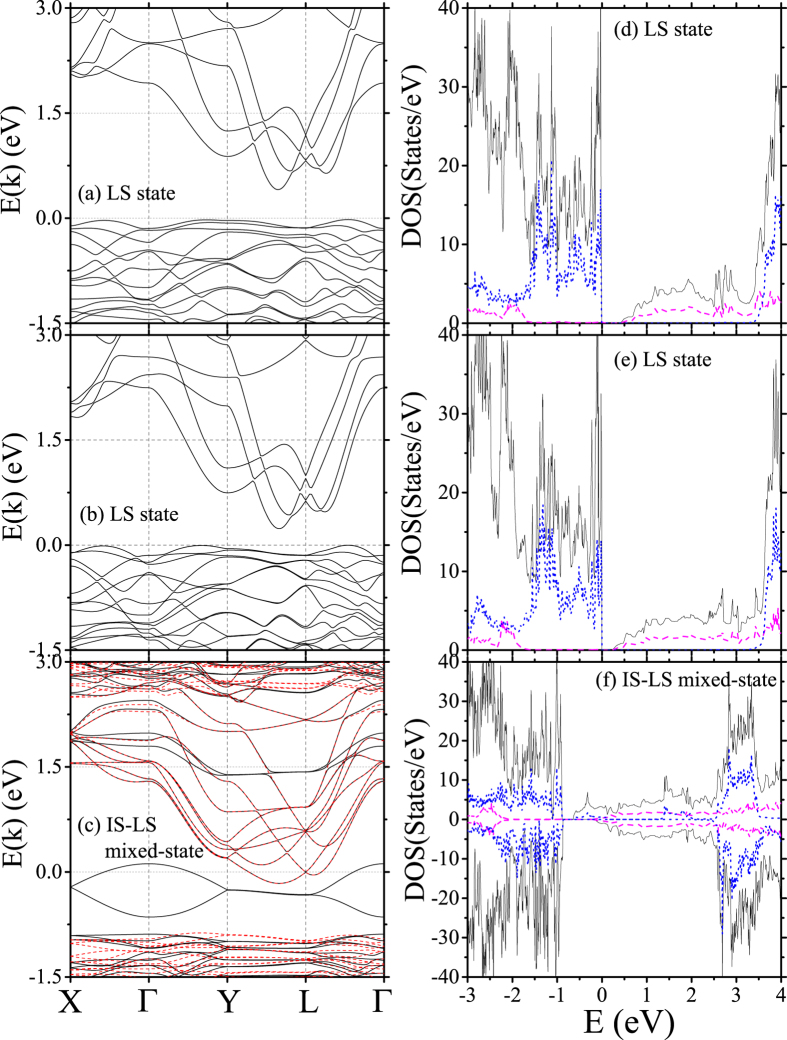
The band structures and densities of states of Bi2A2Co2O8 compounds.The black (solid) and red (dashed) lines in (a–c) refer to the bands for spin-up and spin-down electrons. The black (solid), blue (dotted), and pink (dashed) lines in (d–f) refer to the total, Co-, and Bi-resolved partial densities of states. The Fermi energy is set as  eV. (a,d) Bi2Ca2Co2O8; (b,e) Bi2Sr2Co2O8; (c,f) Bi2Ba2Co2O8.